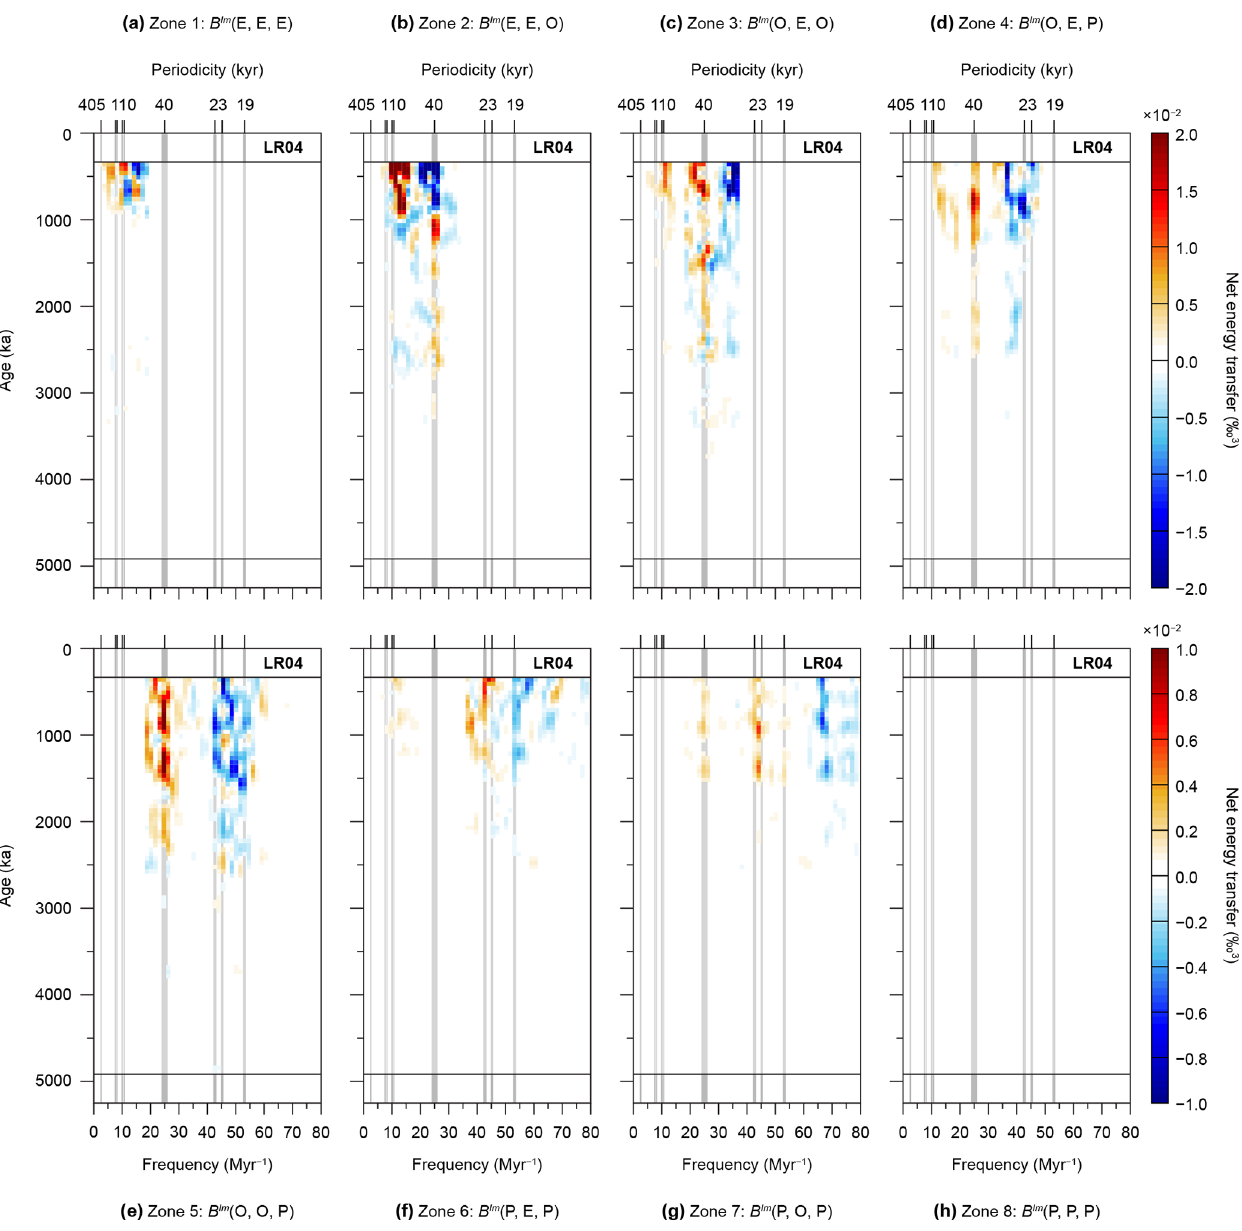
Figure 8. Disentangling “black box” climate. Conservative net energy transfers during the Pliocene and Pleistocene over specific zones in the imaginary part of the bispectrum (see methods section). Computational settings are as in Fig. 5b. (a) Zone 1. (b) Zone 2. (c) Zone 3. (d) Zone 4. (e) Zone 5. (f) Zone 6. (g) Zone 7. (h) Zone 8. See also Fig. 3 and Table